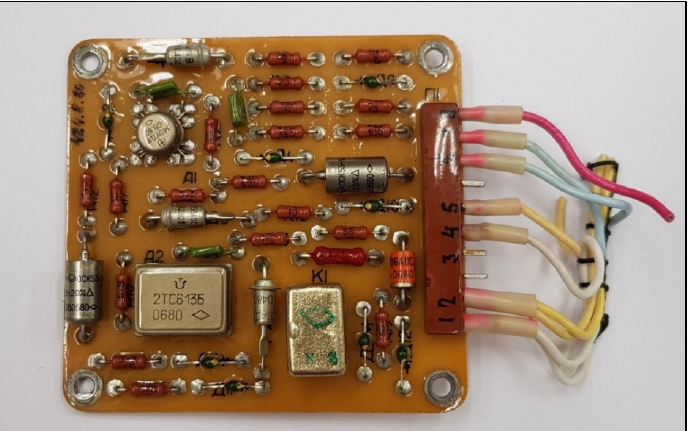
Figure 4. Amplifier board of the BI-2A block seen from the side of the electronic components.